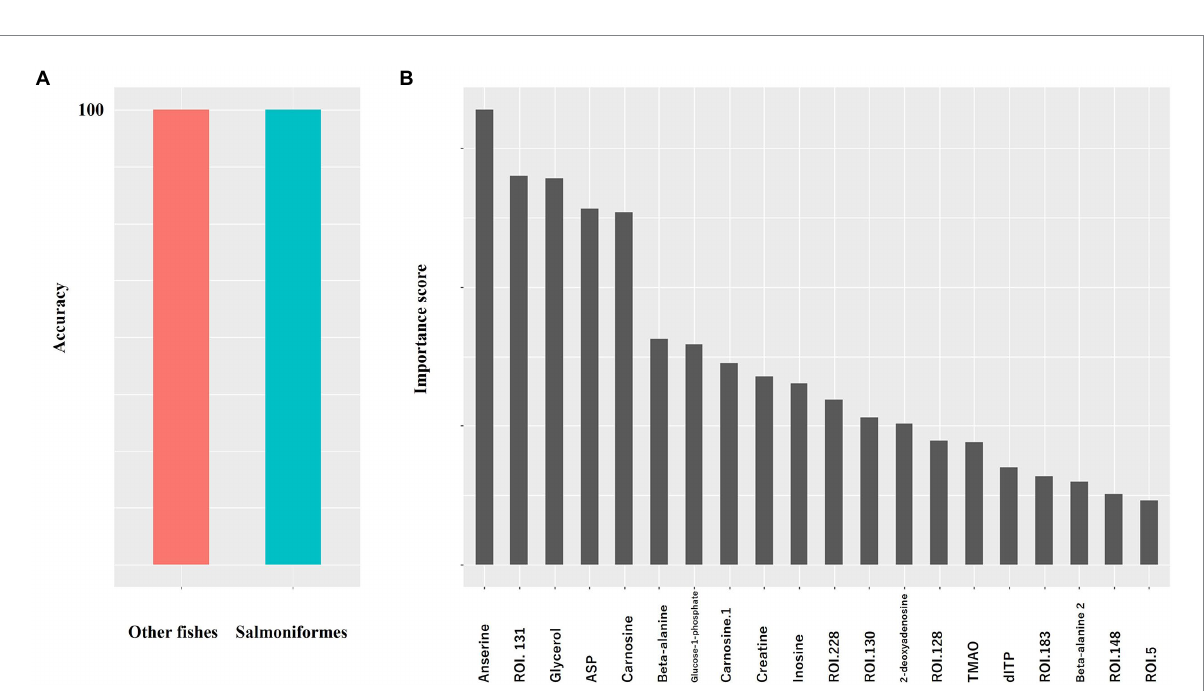
FIGURE 1 Random forest results of metabolite data to classify other fishes and salmoniformes. We used pooled data for other fishes (other fishes: n = 1858, salmoniforems: n = 110). (A) The accuracy of classification was determined using random forest. Values are the averages of five measurements; however, the values were not dispersed. (B) In NMR, a higher score indicates a higher importance to classify. The importance scores are shown in Table